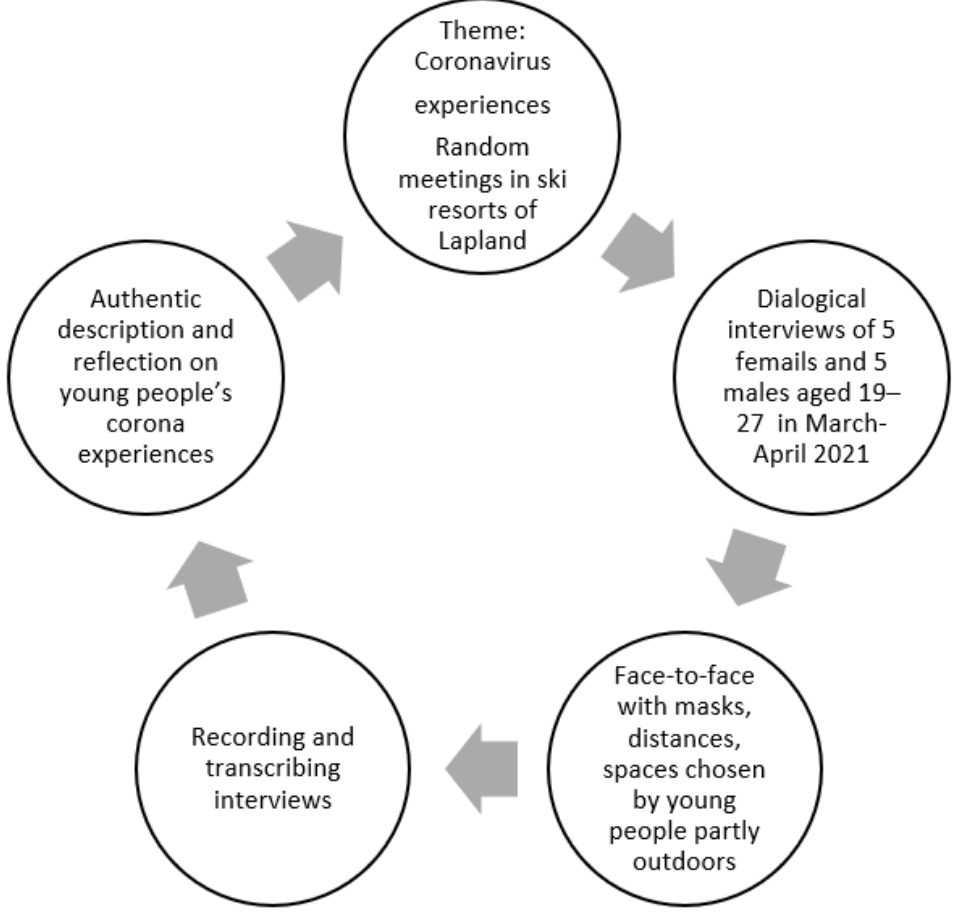
Figure 1. Collection of research material.